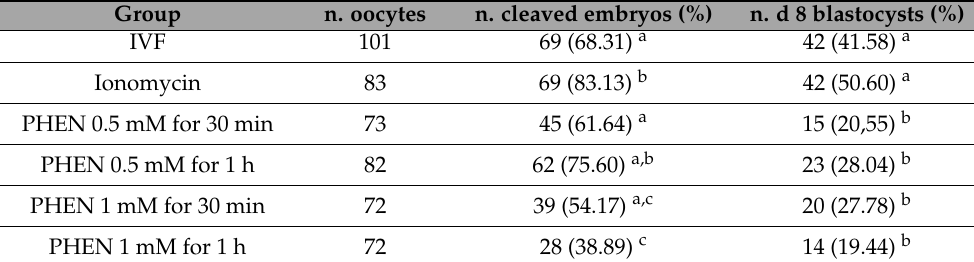
Table 3. In vitro preimplantation development of parthenogenetic bovine embryos using the Zn chelator PHEN in Talp-h media at different incubation conditions. Group n.